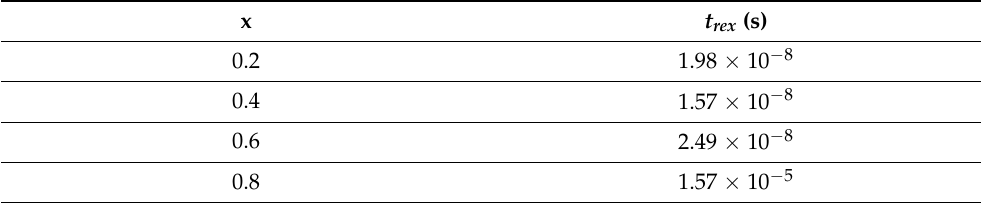
Table 4. Relaxation time for Li 1+x Al x Ti x Sn 2 − 2x (PO 4 ) 3 (x = 0.2, 0.4, 0.6,